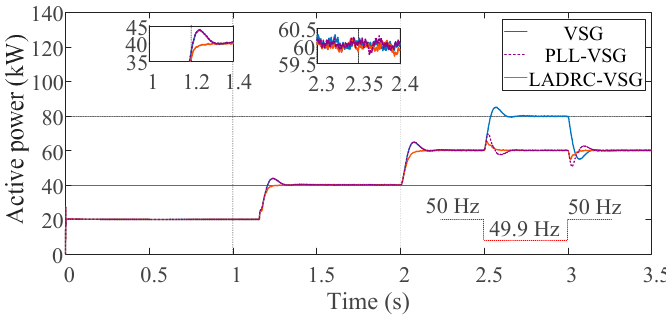
Figure 16. Output active power of VSG under different control strategies.